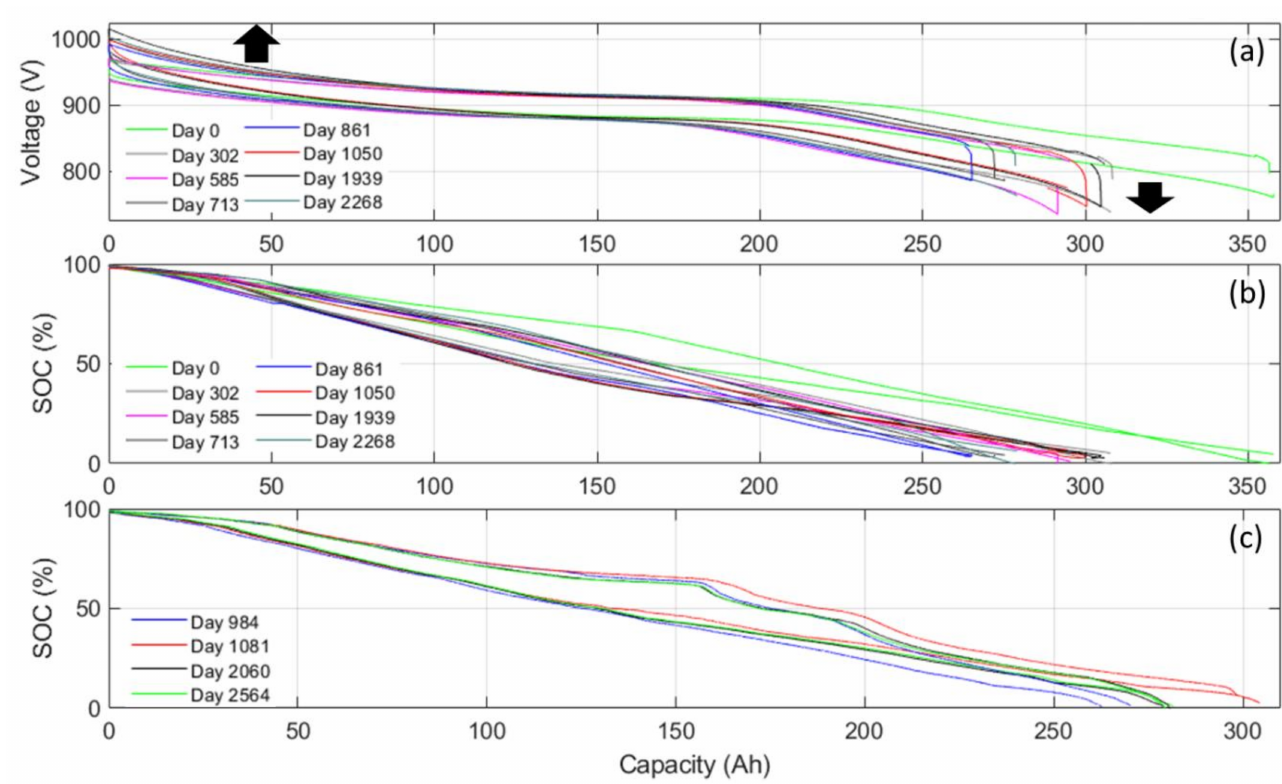
Figure 6. ( a ) Voltage vs. capacity curves for the MRT Energy tests. And ( b ) associated SOC vs. capacity curves. ( c ) SOC vs. capacity curves for the HRT tests. Arrows on ( a ) indicates overall evolution with aging.